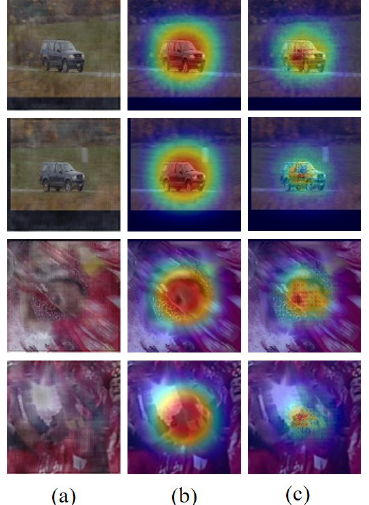
Figure 4. Visualization of the reconstructed attention maps ( Carscale , and Soccer ). ( a ) indicates an estimated target patch; ( b ) is a cosine window that is used to minimize background information; and ( c ) row is a visualized reconstructed attention maps through our structure–attention network. Unlike the unbalanced weighting mechanism of the cosine window that can capture the unnecessary background features, our structure–attention network can capture and highlight the robust target information.